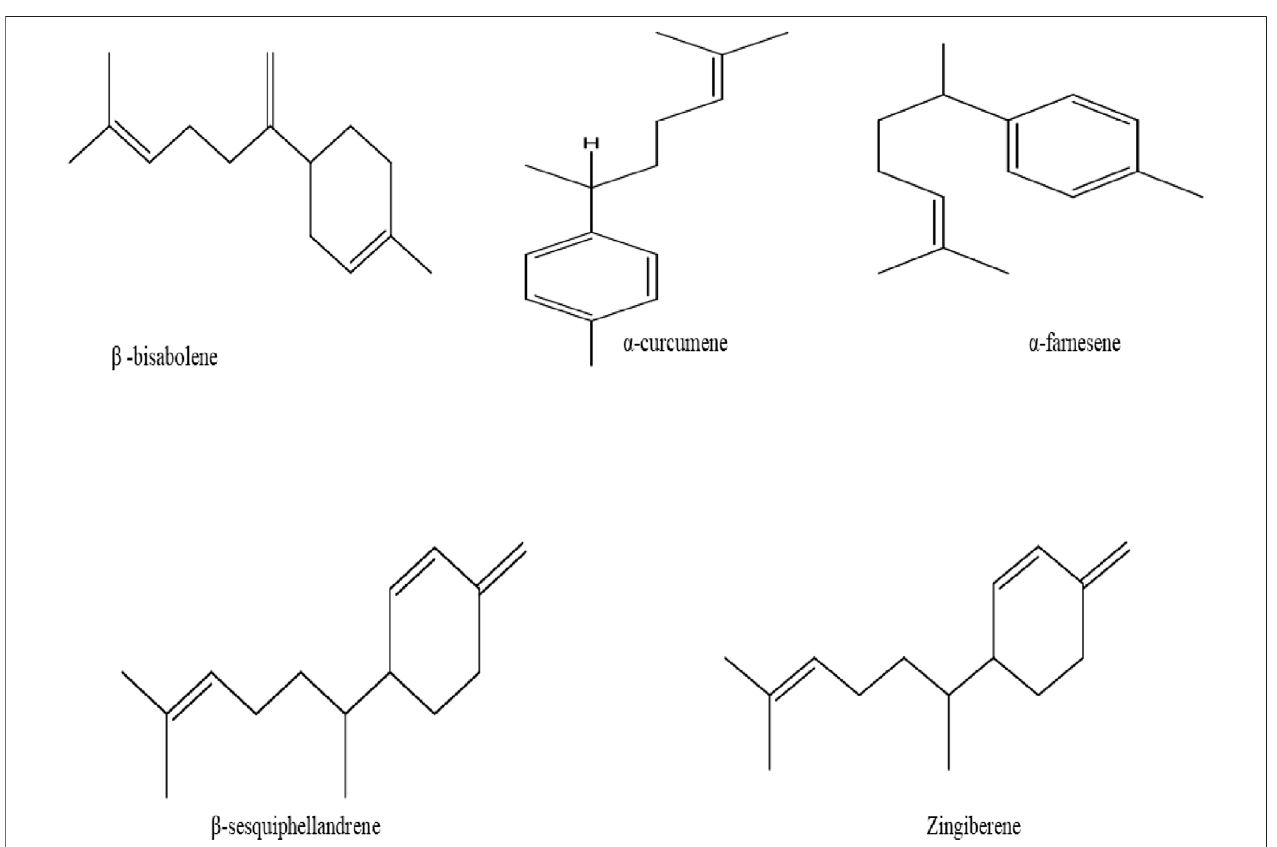
FIGURE 5 | Chemical structure of β -bisabolene, α -curcumene, α -farnesene, β -sesquiphellandrene, and zingiberene isolated from ginger.